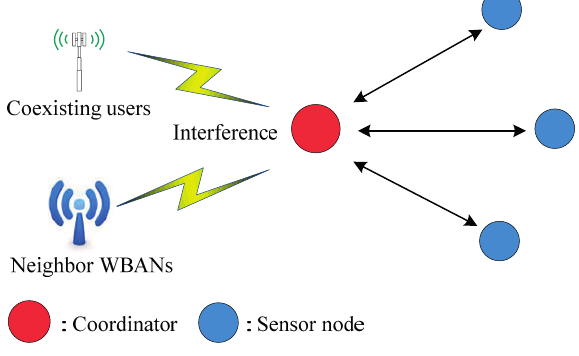
Figure 3. Conceptual operation in cognitive-receiver initiated cycled receiver